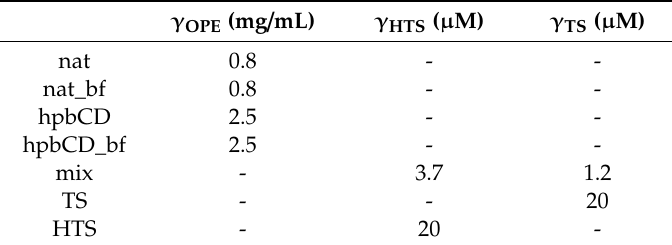
Table 1. Final concentrations of the samples in